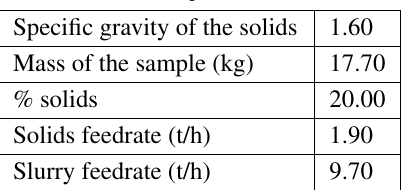
Table 3. Cleanerspiral test